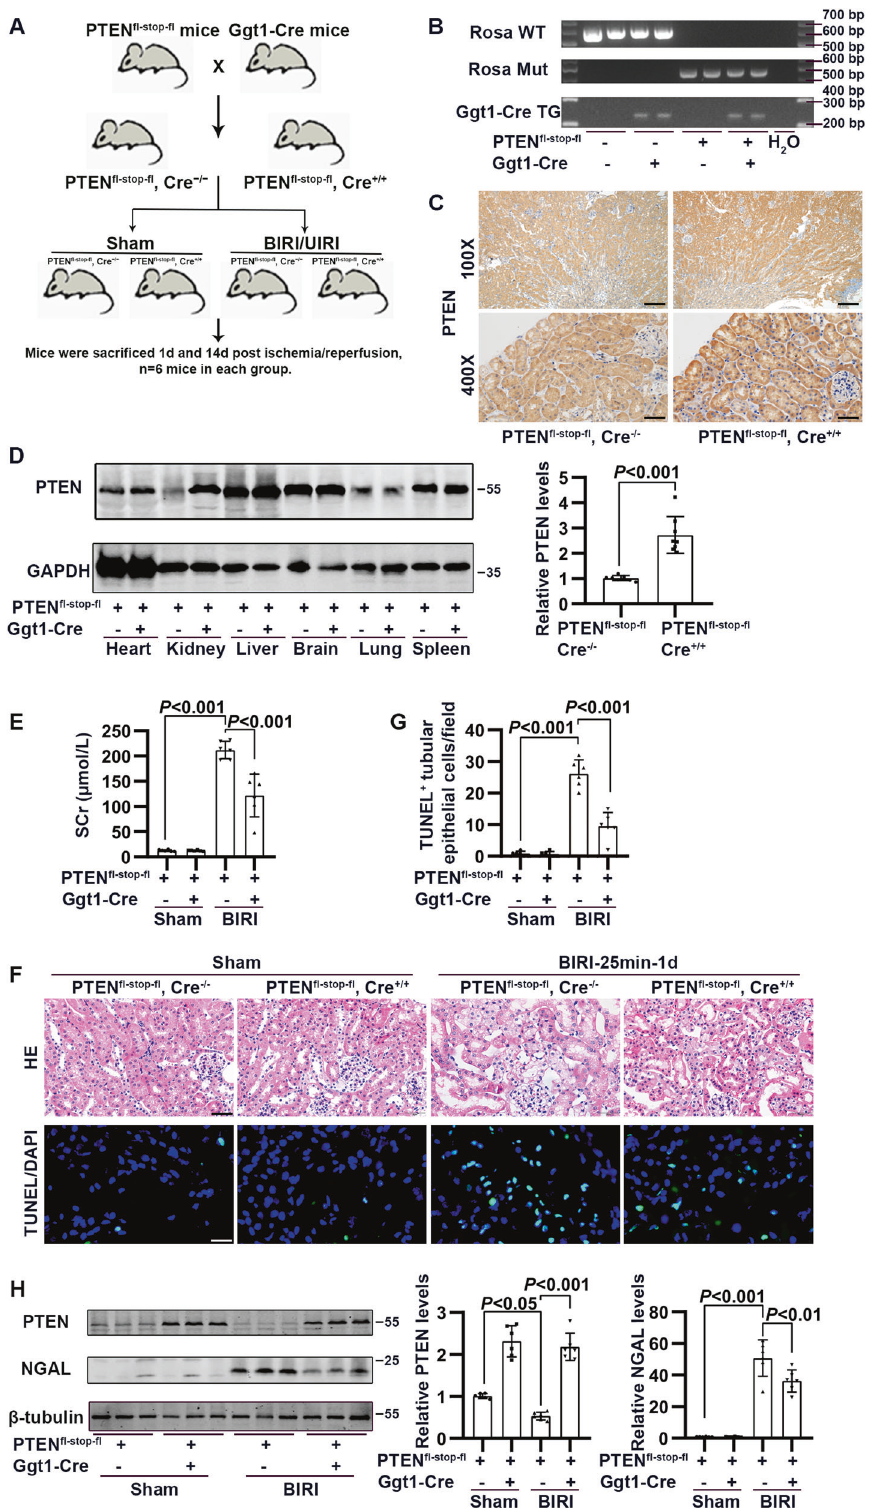
HK-2 cells, silencing CHMP2A aggravated the accumulation of autophagosome-bound LC3-II and P62 and elevated NGAL expression. Importantly, in the presence of si-CHMP2A, over- expression of PTEN failed to promote autophagy fl ux and reduce NGAL expression (Fig. 8A). Consistently, fl uorescent RFP-GFP-LC3